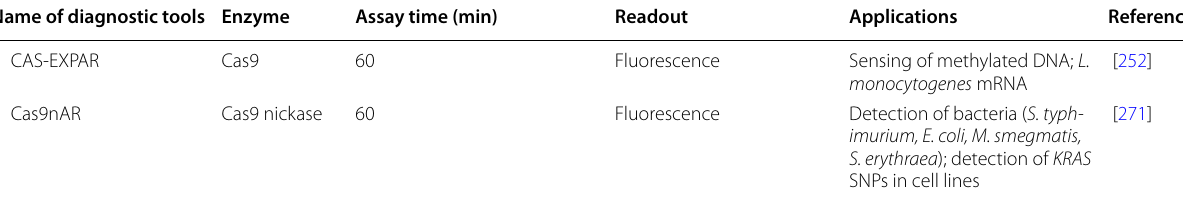
Outlook of CRISPR‑based molecular diagnosis In recent years, the field of the CRISPR diagnosis has expanded rapidly, growing from the specific set of molecular biological discoveries to several active clinical trials (Clini-